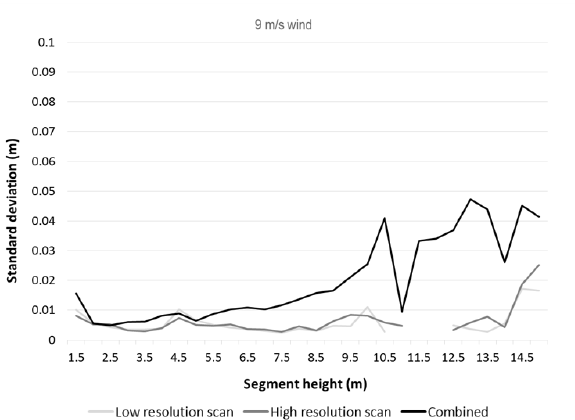
Figure 5. The standard deviation of points from the centre point of the fitted circle at different heights under 3 m/s and 9 m/s wind conditions.